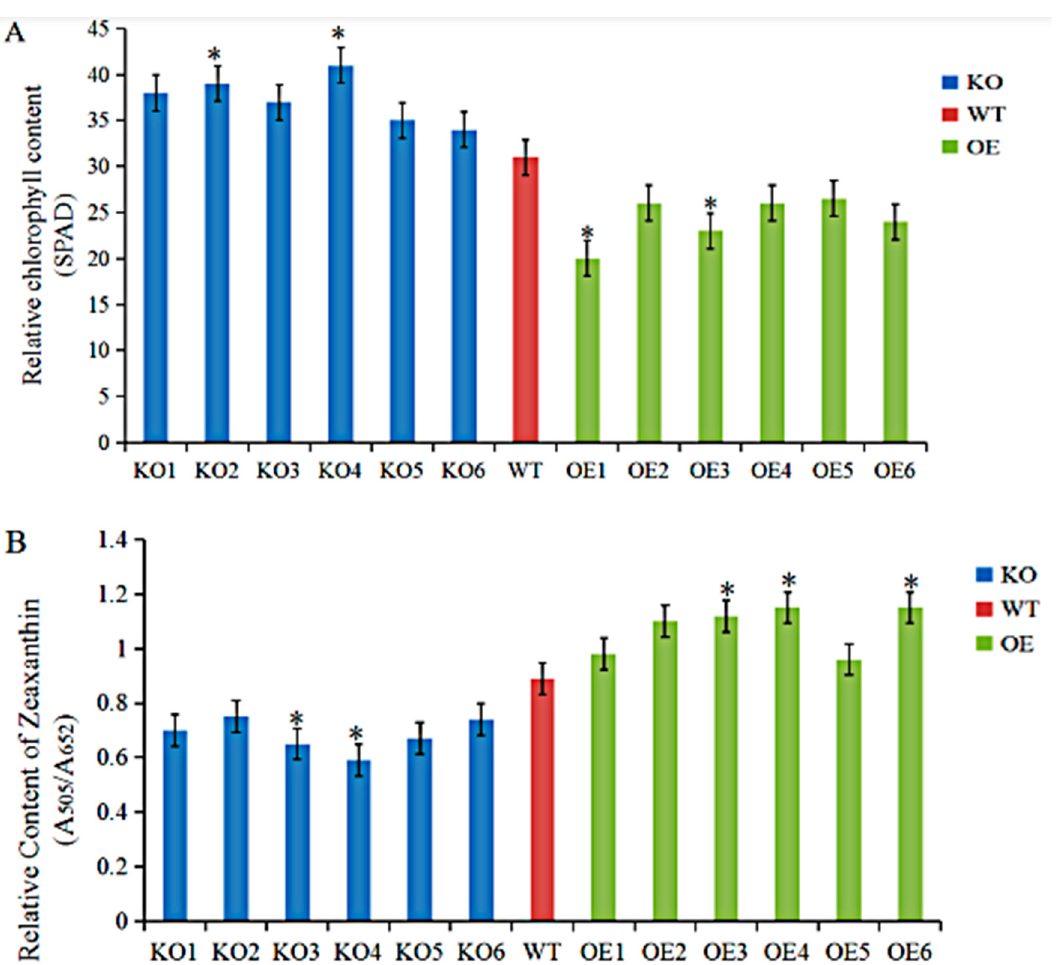
Figure 6. NPQ-related physiological indicators of WT and the T 3 generation of GmRIQ2 - like- OE and - KO transgenic one-month seedlings. ( A ) SPAD values of WT and GmRIQ2 - like -OE transgenic soybean seedlings were detected using a SPAD-502 Chl meter to obtain the relative contents of Chl. ( B ) The relative zeaxanthin contents of WT, GmRIQ2 - like -OE, and - KO transgenic soybean seedlings were detected using a spectrophotometer at 505 and 652 nm. Vertical bars represent the SE ( n = 3; each treatment consisted of 30 seedlings). Asterisks indicate significant differences (* p < 0.05) between the transgenic lines and WT.